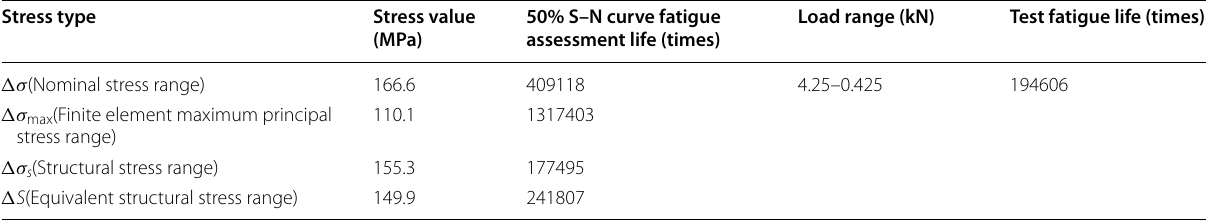
Table 8 Comparison of bending fatigue test results and evaluation life of test sample type 2 Stress